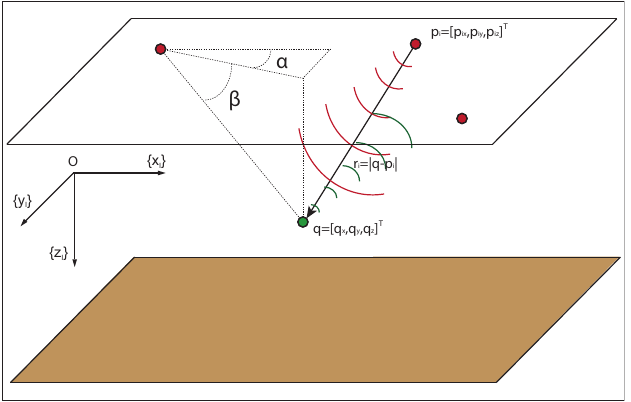
Figure 1. Elevation and azimuth angles measured in the inertial coordinate frame used in marine